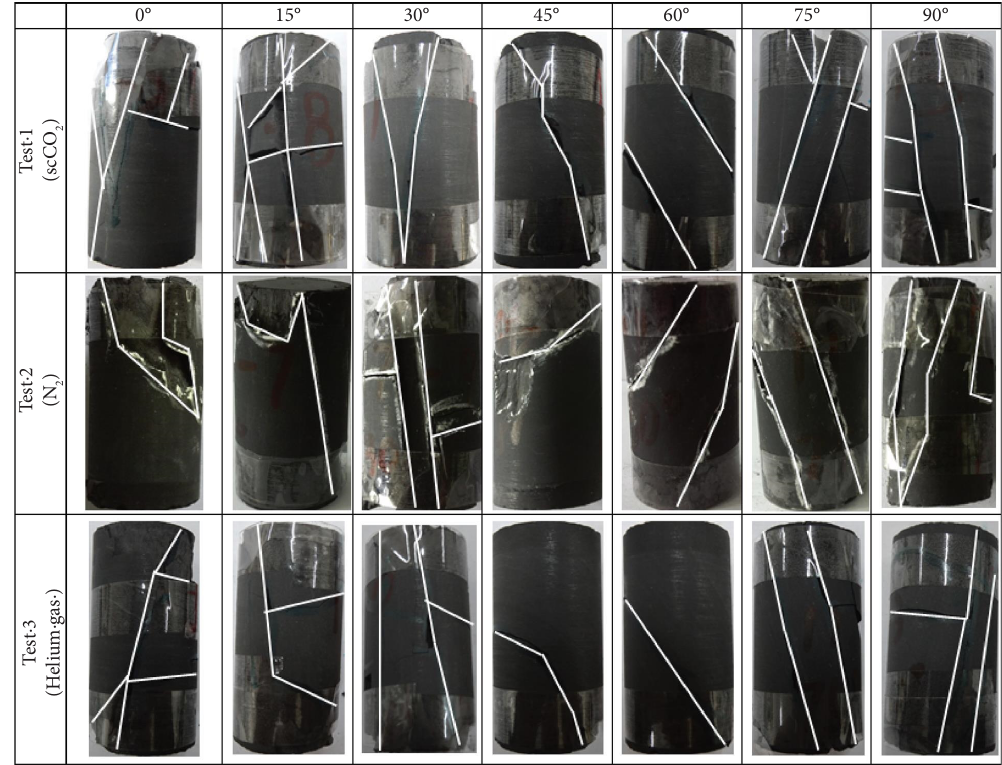
Figure 11: Te shale failure modes picture of diferent experimental conditions and diferent coring